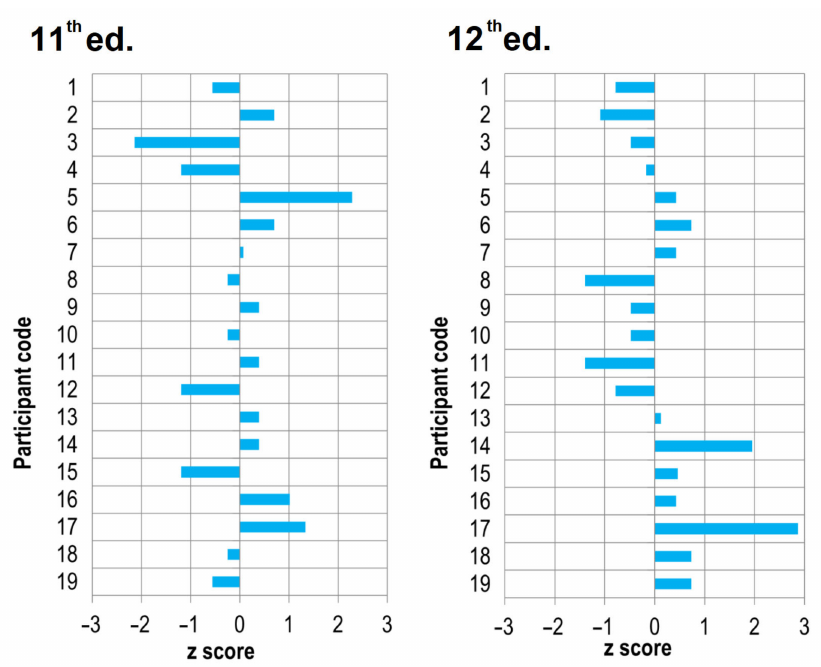
Figure 1. The z-score value for the initial tensile adhesion strength for each of 19 laboratories participating in the eleventh and twelfth editions of the ILC.